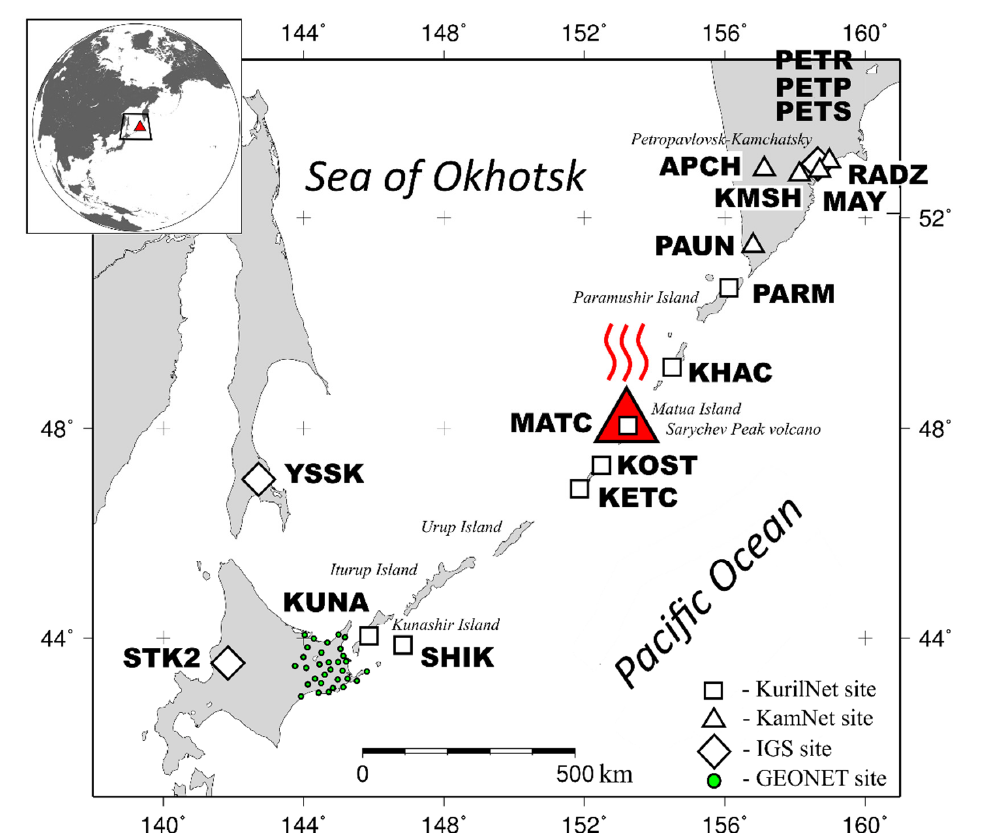
Figure 1. The map of the Kuril Islands Arc and distribution of GPS sites used in this study. The location of Sarychev Peak volcano (Matua Island) is denoted by the red triangle. GPS station names are given in bold. Other notations are shown in the figure. Table 1. The main characteristics of the largest eruptive events with explosion plume altitudes ≥ 10 km above the sea level. The start time and duration of each paroxysm are given according to infrasonic observations [17]. The eruptive column height was estimated by satellite data and analysis at SVERT—Sakhalin Volcanic Eruption Response Team (http://www.imgg.ru/ en/svert (accessed on 25 December 2020)). Amplitude of infrasonic signals is given for the nearest global IMS infrasonic network site located in Petropavlovsk-Kamchatsky [17]. The background total electron content(TEC) values were calculated by using IRI2016 online reference ionosphere model